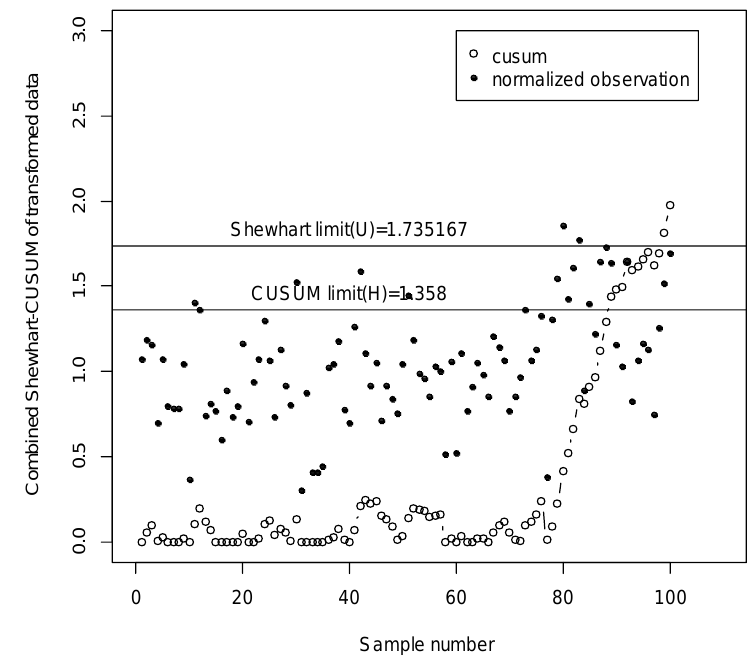
Figure 1. Combined Shewhart-CUSUM chart for transformed exponentially distributed data with ARL =